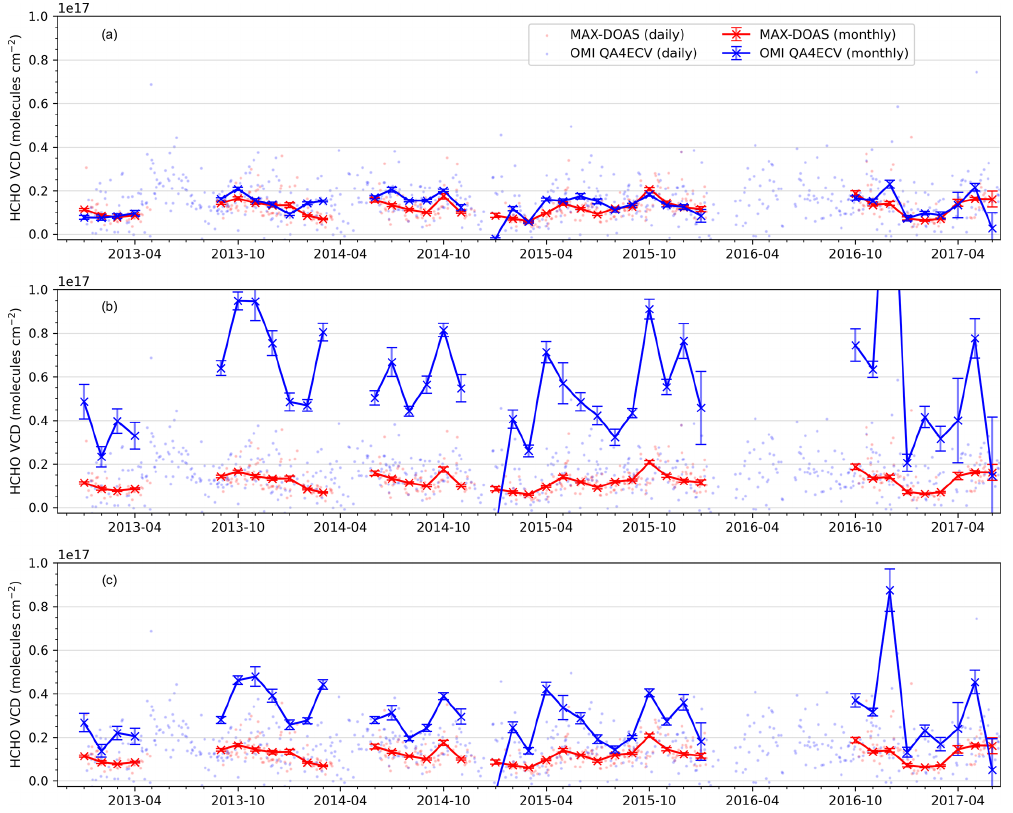
Figure D4. Time series of the MAX-DOAS and OMI QA4ECV HCHO tropospheric VCDs for (a) when no modifications in the a priori profiles are applied, (b) when the a priori profiles of QA4ECV are replaced by the MAX-DOAS profiles, and (c) when the lowest 2.5km of the a priori profiles are replaced by corresponding MAX-DOAS